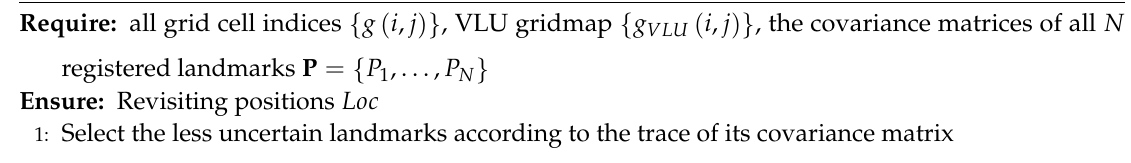
Algorithm 1 Selecting revisiting